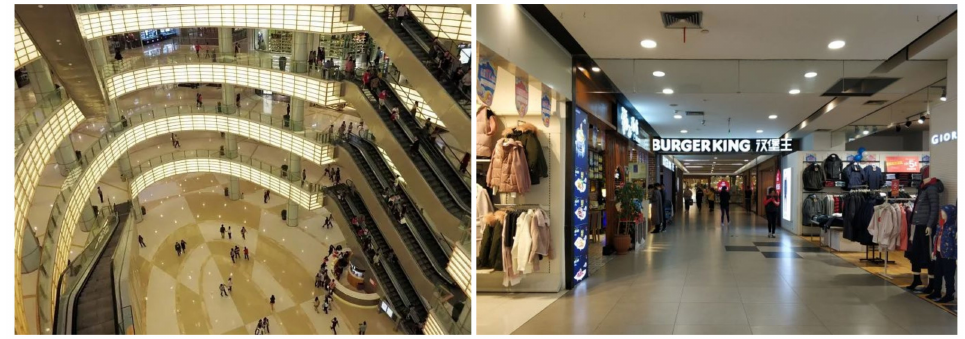
Figure 7. Pictures of Zhixin Cheng, Hefei